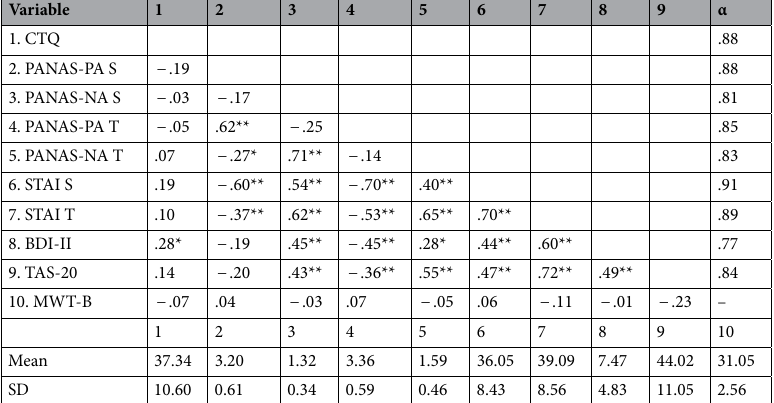
Table 1. Descriptive statistics of and correlations between self-report and test scores (N = 58) with Cronbach’s alpha for self-report questionnaires. CTQ Childhood Trauma Questionnaire, PANAS-PA S Positive and Negative Affect Schedule, positive affect scale, state (mean item score), PANAS-NA S Positive and Negative Affect Schedule, negative affect scale, state (mean item score), PANAS-PA T Positive and Negative Affect Schedule, positive affect scale, trait (mean item score), PANAS-NA T Positive and Negative Affect Schedule, negative affect scale, trait (mean item score), STAI S State Trait Anxiety Inventory, state version, STAI T State Trait Anxiety Inventory, trait version, BDI-II Beck Depression Inventory, TAS-20 20-Item Toronto Alexithymia Scale, MWT-B Mehrfachwahl-Wortschatz-Intelligenztest version B. *p < .05; **p <